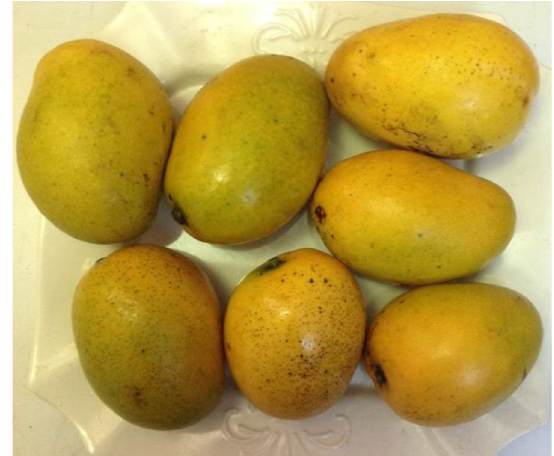
Fig. 6 Mangifera indica fruits (Ogbomosho variety, Nigeria). Source: